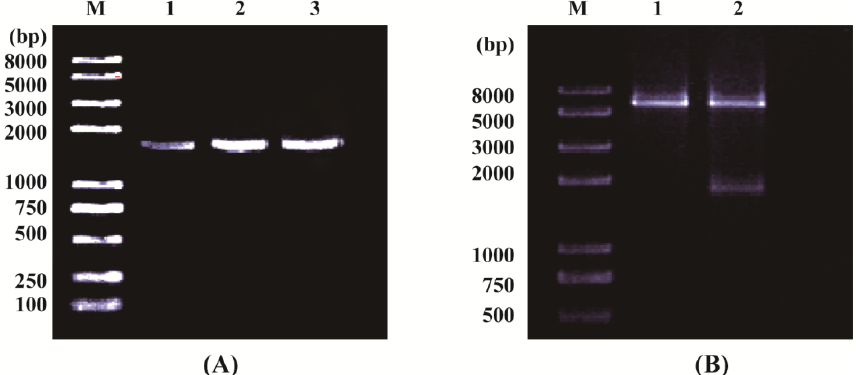
Figure 1. Polymerase chain reaction (PCR) amplification and restriction analysis of OsPOP5 in rice. ( A ) OsPOP5 was isolated and amplified as described in Materials and Methods Section. Lanes 1 , 2 and 3 are all OsPOP5 gene amplified in rice. Lane M : DNA ladder (PCR marker); Lanes 1 , 2 and 3 , PCR product of OsPOP5 (~1804 bp); ( B ) Restriction analysis of pET32a-OsPOP5. Lane M : DNA ladder (PCR marker); Lane 1 : restriction